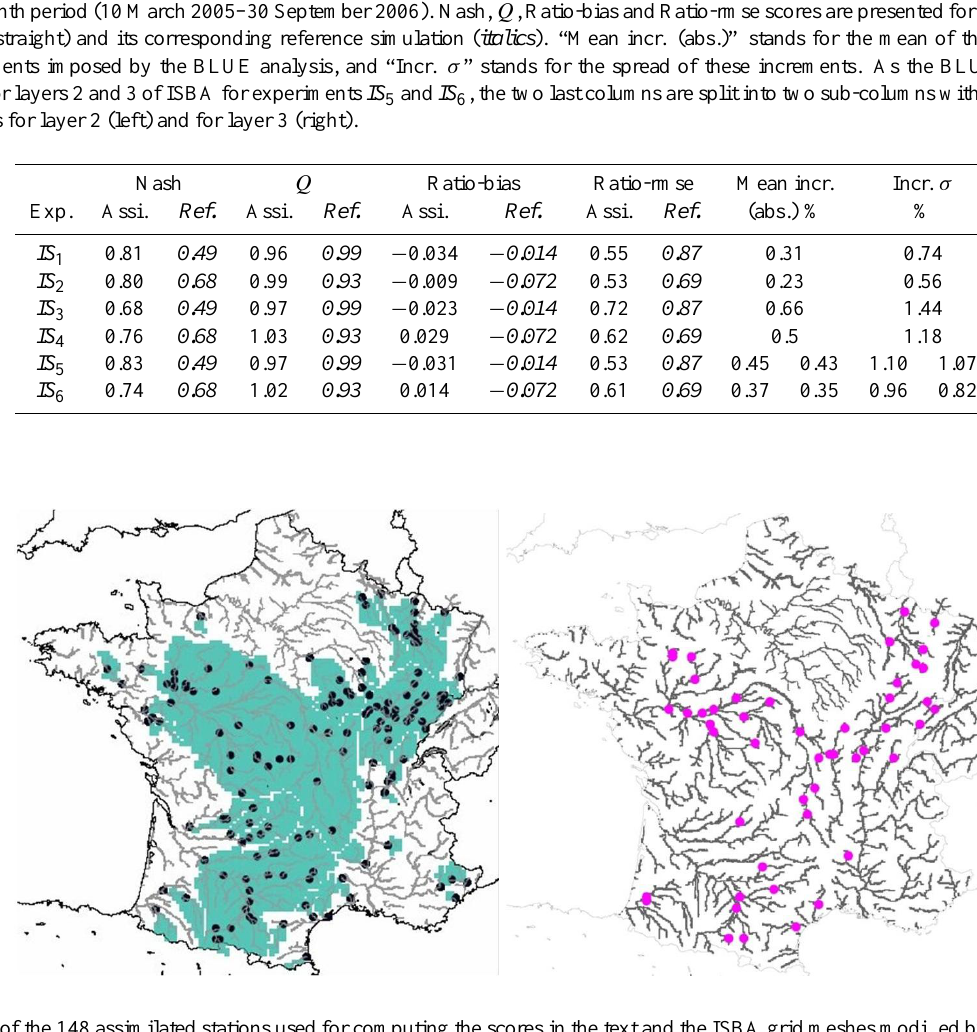
Fig. 5. Maps of the 148 assimilated stations used for computing the scores in the text and the ISBA grid meshes modified by the BLUE (left) and the 49 stations used for the independent validation of the assimilation system (right).